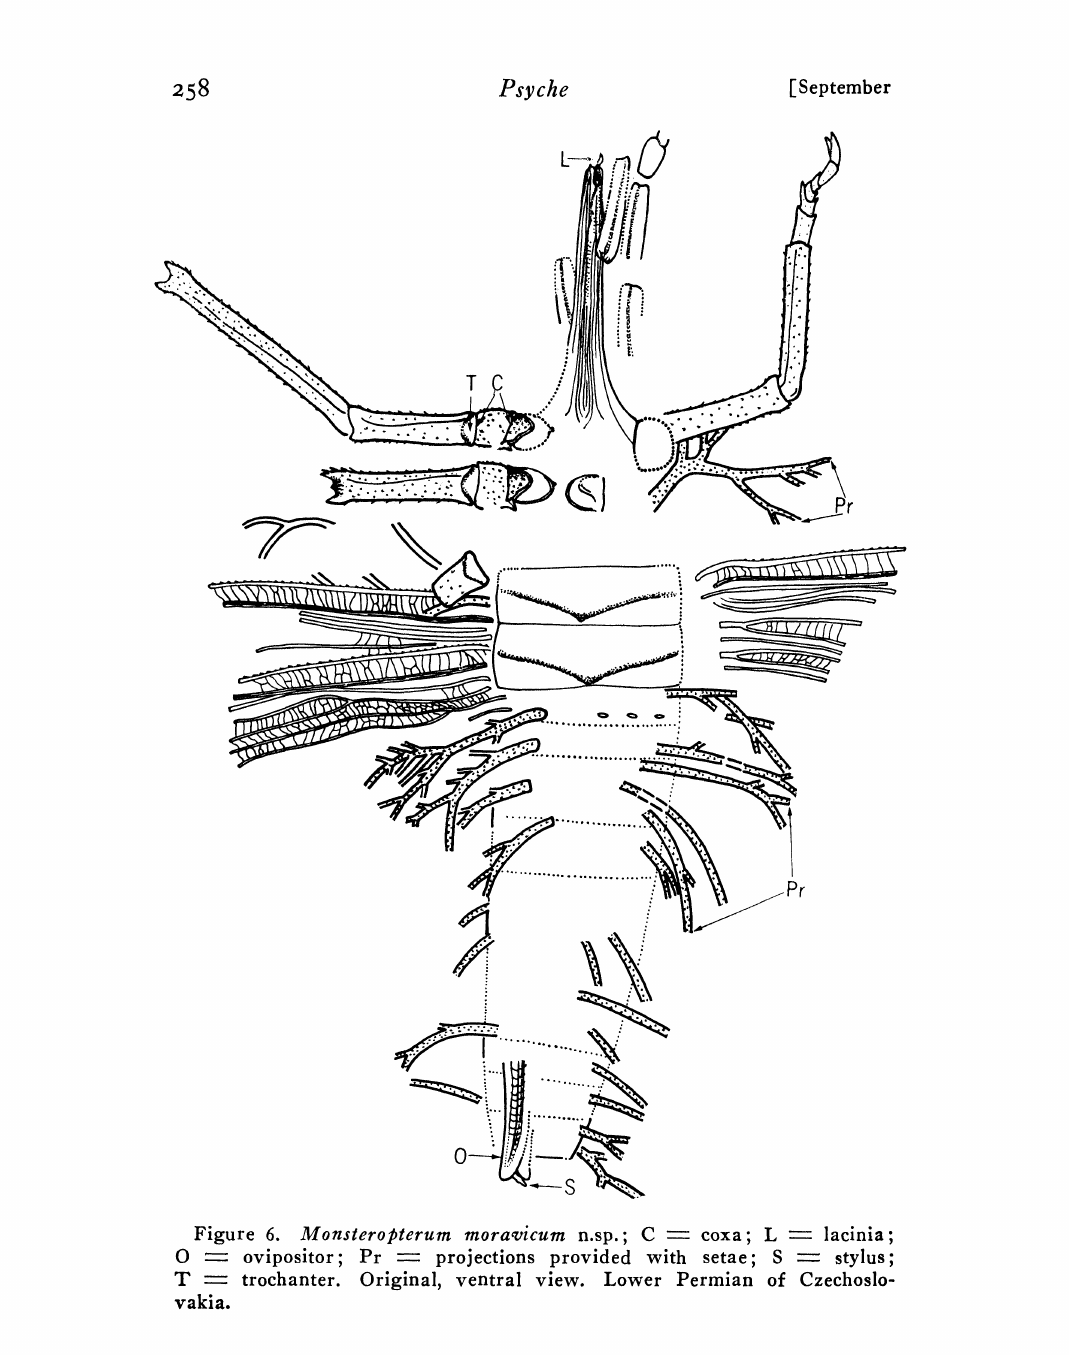
Figure 6. Monsterotterum mora,icum n.sp.; C coxa; L lacinia; O ovipositor; Pr projections provided with setae; S stylus; T troehanter. Original, ventral view. Lower Permian of Czechoslo-